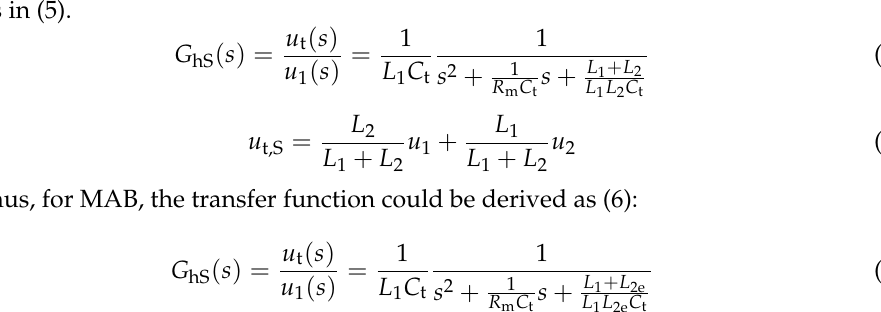
Figure 6. Experimental voltage waveform with different AC resistances. Then, ignoring the AC resistance of the loop, the transfer function could be simplified from the third-order control system to a standard second-order control system, as shown in Equation (4). The steady state value of the u t considering both u 1 and u 2 was calculated as follows in